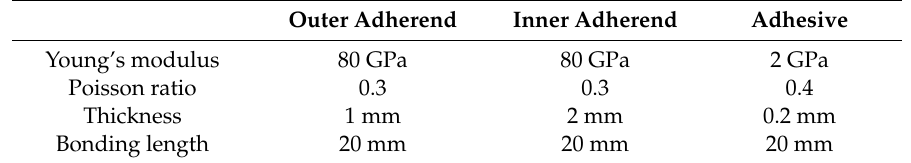
Table 2. Materialproperties, thicknessandbondinglengthofthedoublelapjointfortheparametricstudy. Outer Adherend Inner Adherend Adhesive Young’s modulus 80 GPa 80 GPa Poisson ratio 0.3